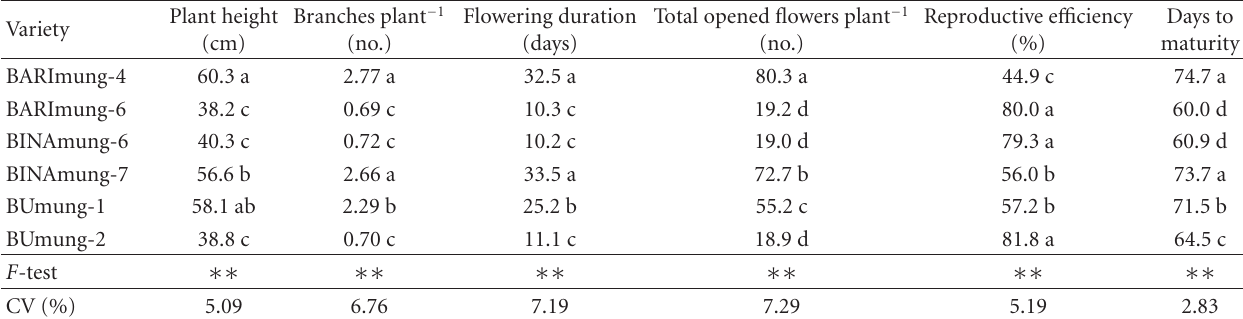
Table 1: Variation in morphological, reproductive, and phenological parameters in six mungbean varieties (mean over two years). Variety